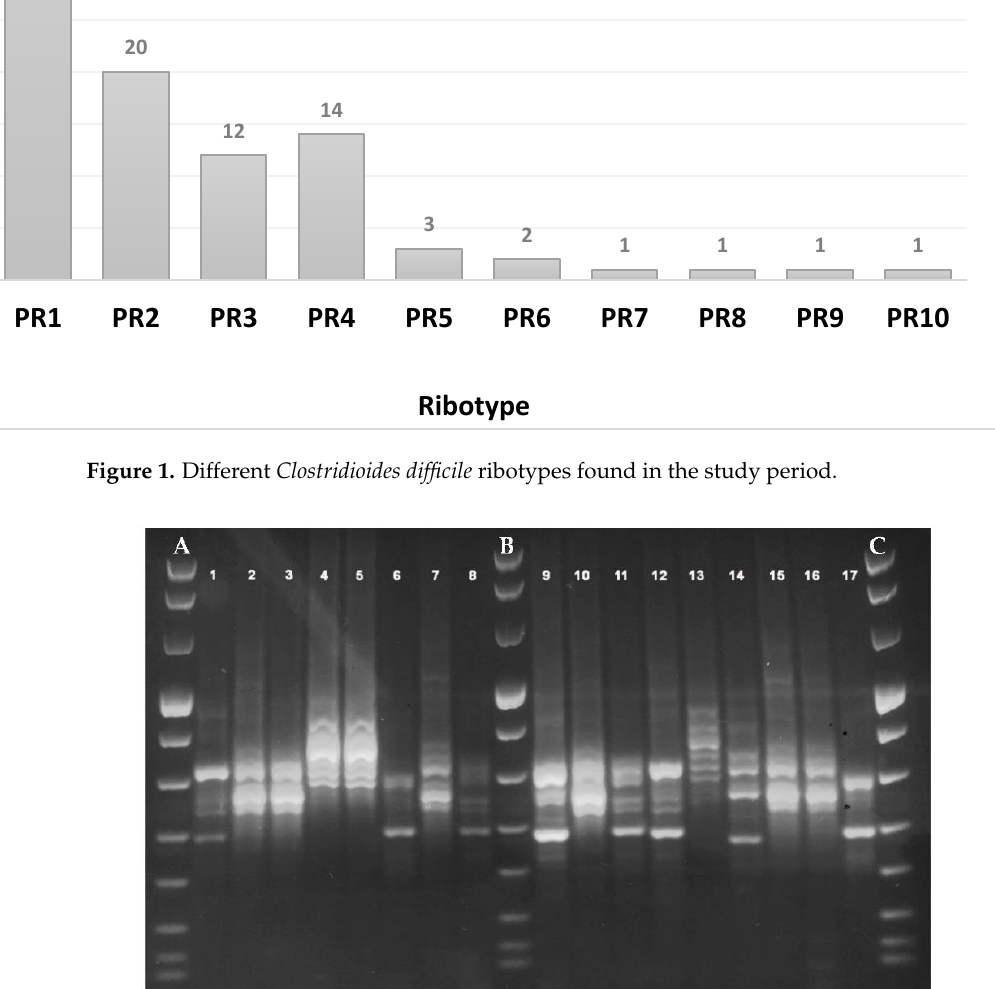
Figure 2. Example of different polymerase chain reaction (PCR)-ribotyping patterns. Lines 2, 3, 7, 10, 15, 16: Ribotype PR1; Lines 1, 8, 11, 12: Ribotype PR2; Lines 6, 17: Ribotype PR3; Lines 4, 5, 13: Ribotype PR4; Line 9: Ribotype PR6; Line 14: Ribotype PR7; Lines A, B, C: 100-bp ladder DNA molecular weight VIII (Roche).